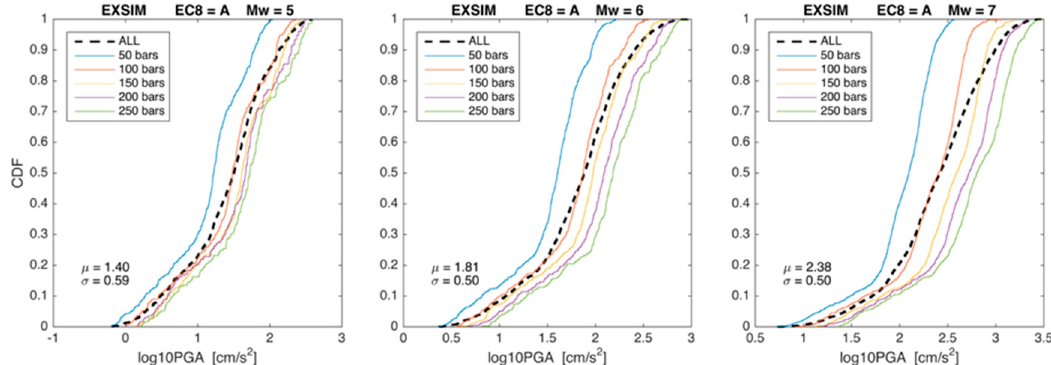
Figure 13. Parametric variability of the GSs simulations (Mw = 5.0, 6.0, 7.0). The cumulative distribution functions (CDFs) are computed through grouping the scenario events that share different stress parameters. All the cumulative distribution functions are compared to the overall distributions of the peak ground acceleration (PGA, black curves). Median values ( µ ) and standard deviations ( σ ) of the synthetic distributions are also reported.